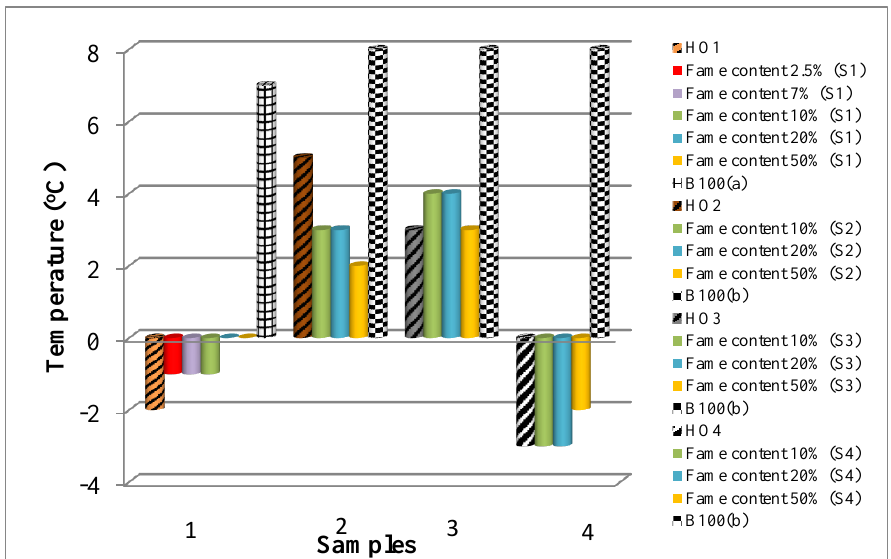
Figure 4. Cloud point (CP) of oil samples.